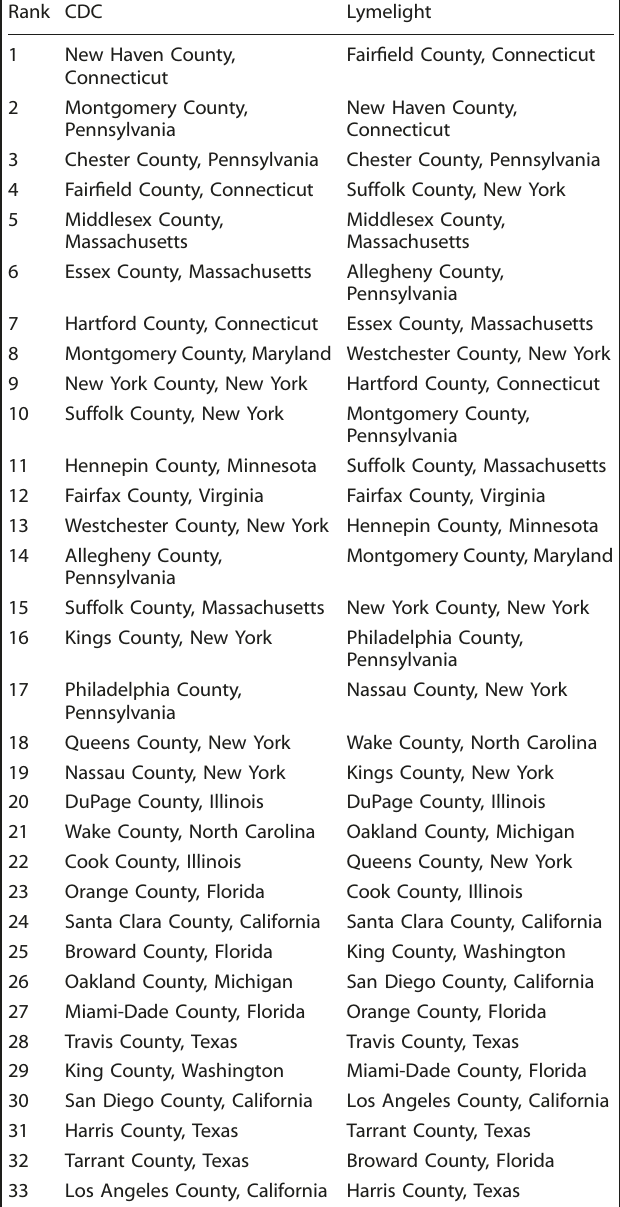
Table 3. Ranking of counties according to CDC and according to